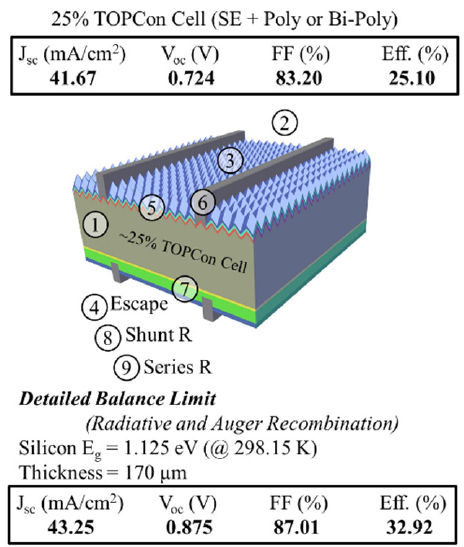
Figure 12. The structural layout of loss factors in TOPCon Solar cell.